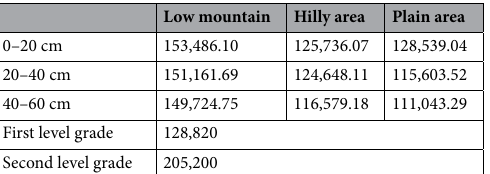
Table 1. Areas of the equal intercept transformation radar charts.